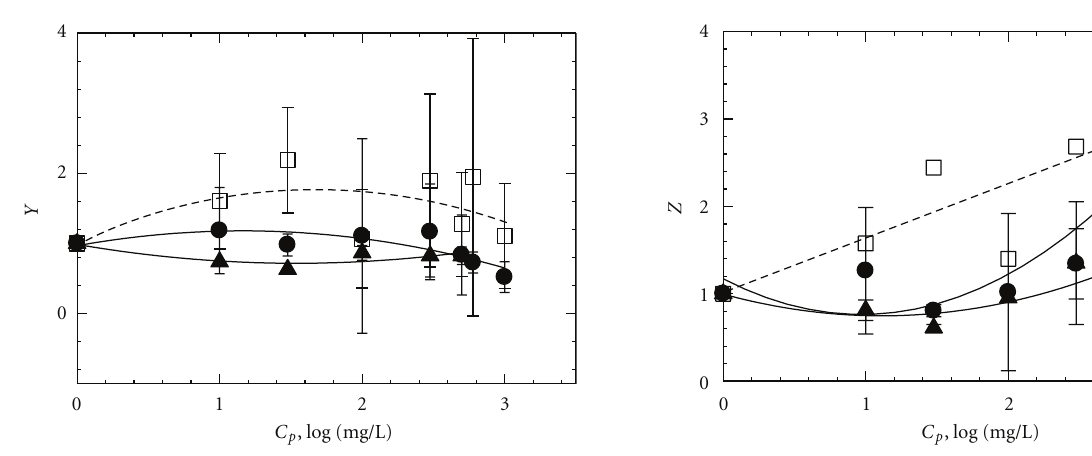
Figure 3: Normalized specific lipid oxidation ( Z ) as a function of the concentration NP. Solid circles are Al 2 O 3 (17.6 nm). Open squares are SiO 2 (14.3nm). Solid triangles are TiO 2 (18.7nm). Error bars are ± 1 standard deviation. Error bars were omitted from SiO 2 plot. Lines are 2nd-order polynomial fits to the data. Experimental conditions: initial algae concentration = 1 . 4 ± 0 . 9 × 10 6 cell/mL, test duration = 4 days, and initial test volume = 200 mL.